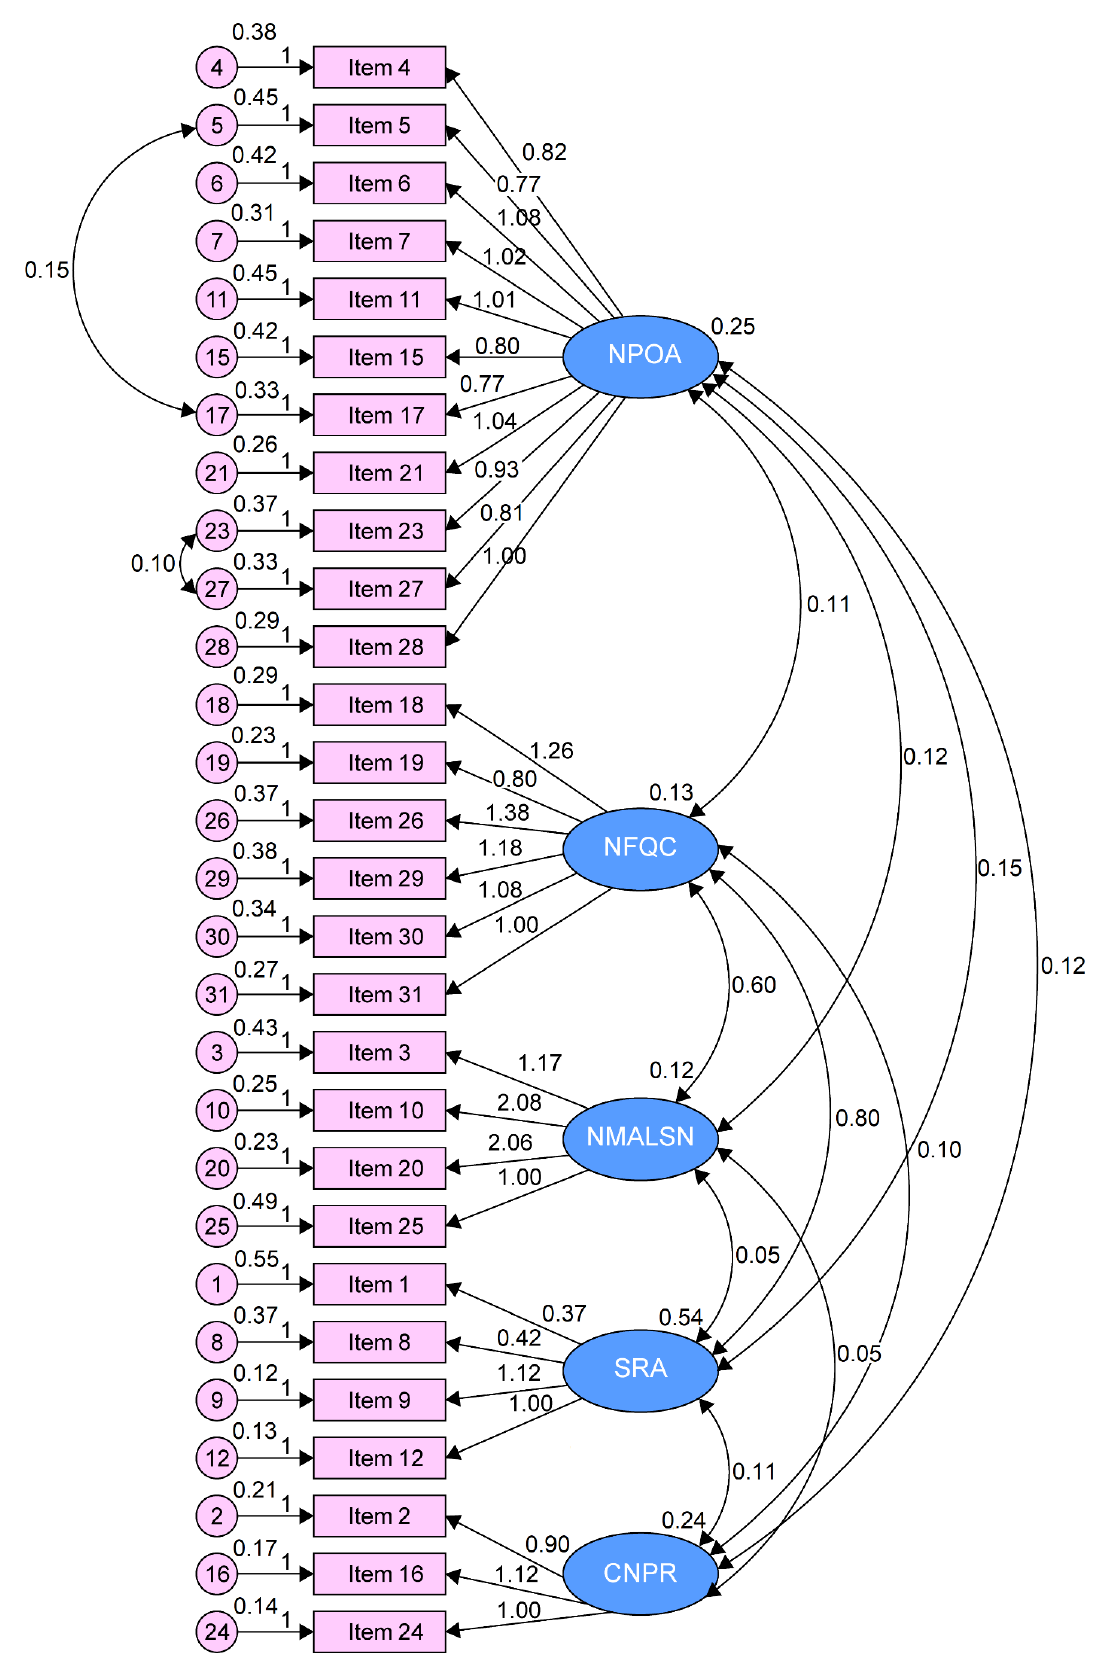
Figure 1. Five-factor model of the Practice Environment Scale of Nursing Work Index (PES-NWI) in primary health care in